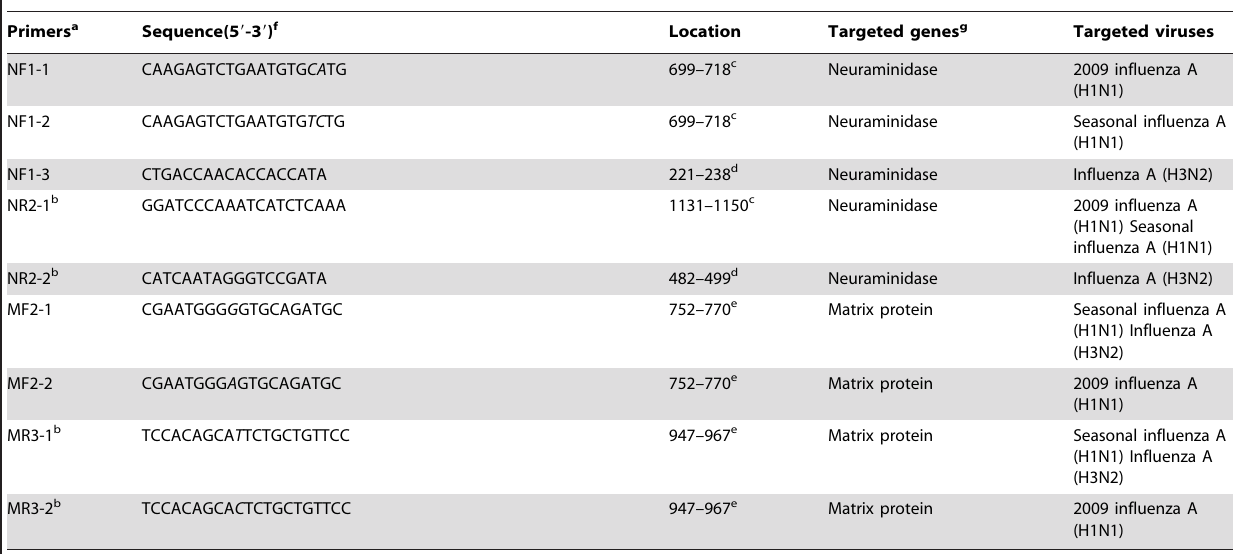
Table 1. The primer sequences for